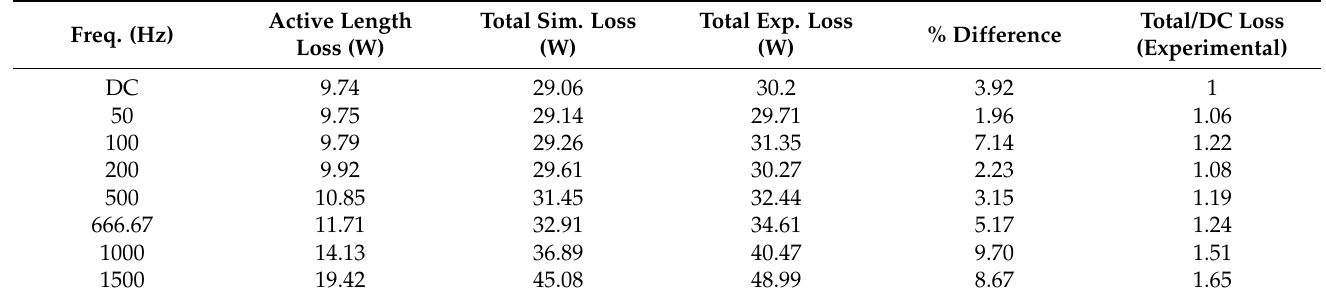
Table 3. Comparison of FEA calculated loss and experimental measured loss.